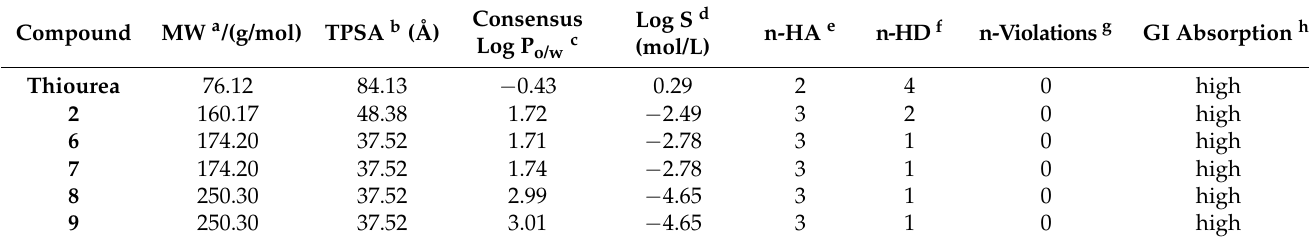
Table 3. Predicted drug-likeness properties of thiourea and the oxime compounds 2 , 6 , 7 , 8 , and 9 .